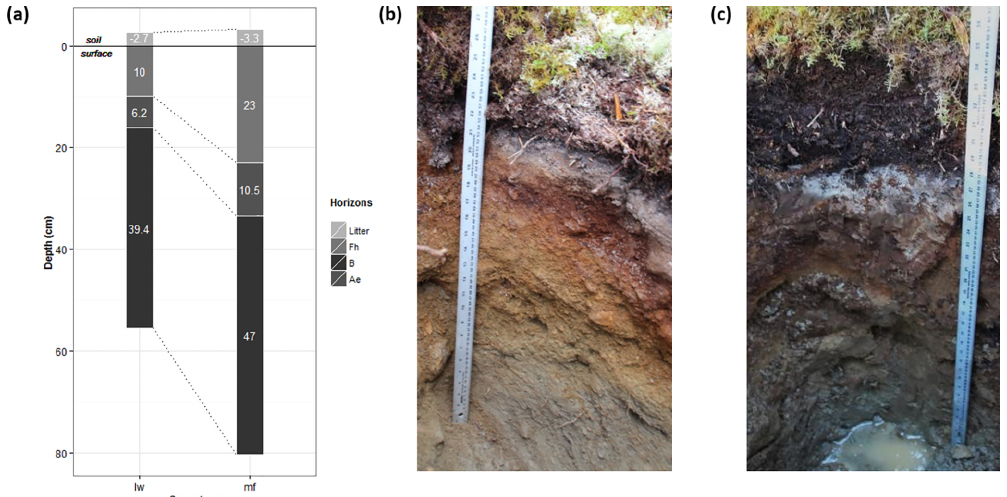
Figure 2. Soil profiles in mf and lw plots. (a) Average thicknesses of the litter, FH, Ae and B horizons. Labels inside stacked bars refer to each horizon’s thickness average. (b) Picture taken in the field of a soil profile representative of lw. (c) Picture taken in the field of a soil profile representative of mf. Soil profiles were composed of a thin eluvial pale grey horizon (Ae), a mineral B horizon whose colour varied between sites from light, reddish to dark brown and faded to paler colours with depth, and a grey mineral C horizon.